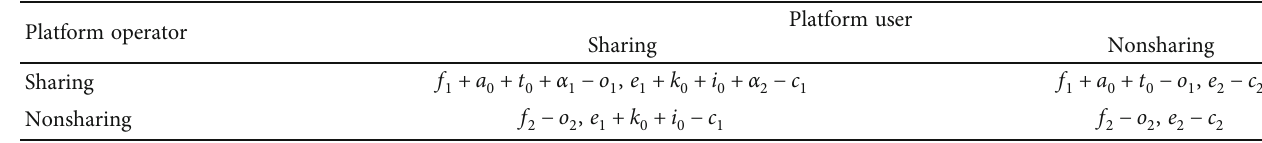
Table 2: Game payment